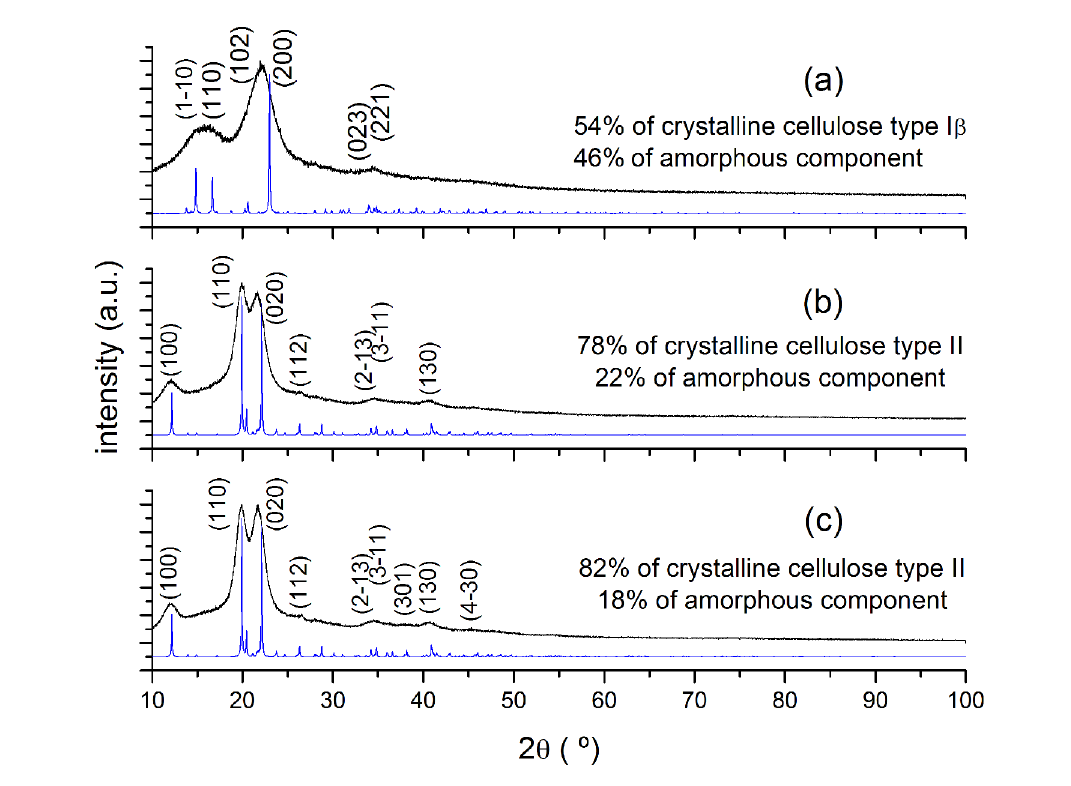
Figure 4. XRD patterns corresponding to: raw bark of Cereus Forbesii (a), cellulose obtained by alkaline treatment (b), and cellulose nanofibers obtained by the acid hydrolysis of cellulose (c). The main indices (h k l) corresponding to the reflections of the crystalline phases are indicated. The calculated XRD patterns of cellulose type Iβ 65 and cellulose type II 69 are